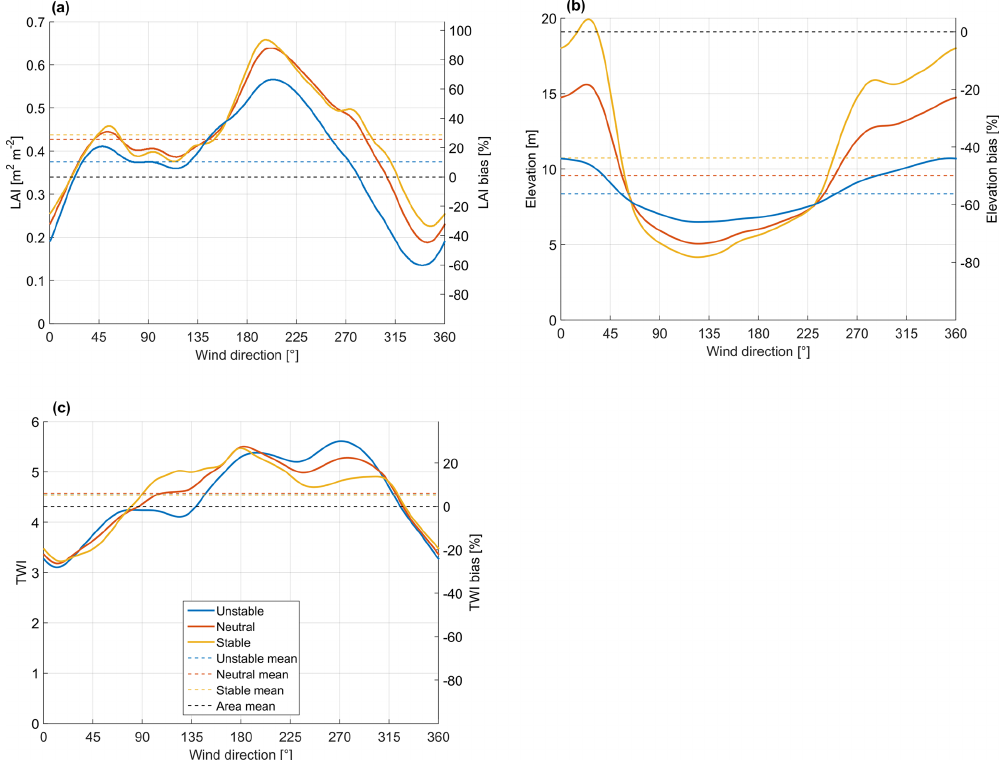
Figure 4. The footprint-weighted and areally averaged leaf area index (a) , terrain elevation (b) and topographic wetness index (c) as a function of wind direction for the three flow condition cases specified in Table 2. The right-hand ordinate indicates the corresponding sensor location